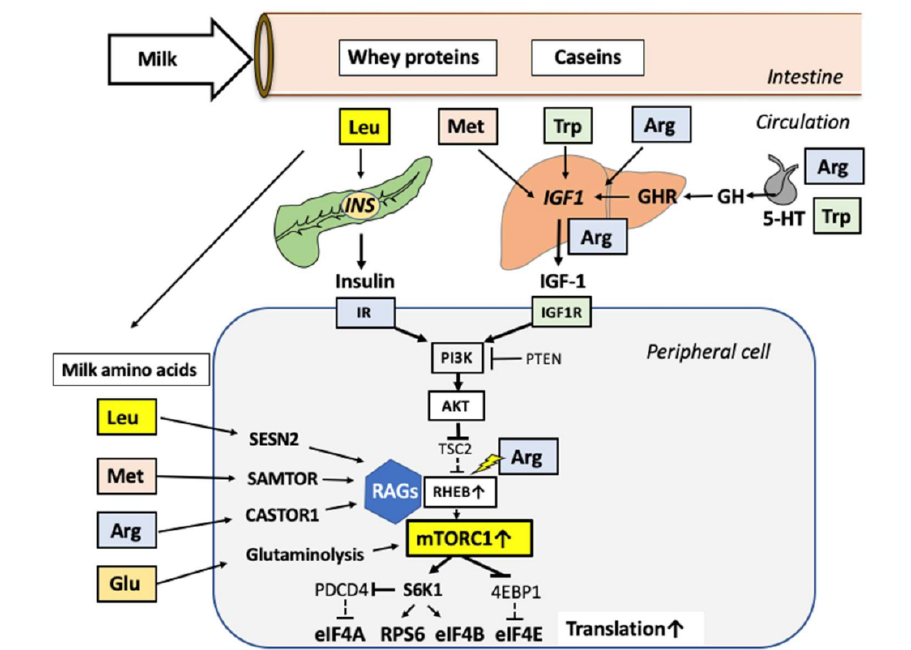
Figure 1. Model of milk amino acid signaling activating mTORC1 directly via amino acid-RAG interaction and insulin/IGF-1/PI3K/AKT signaling activating RHEB at the lysosomal membrane. Abbreviations: GH: growth hormone; GHR: growth hormone receptor; 5-HT: